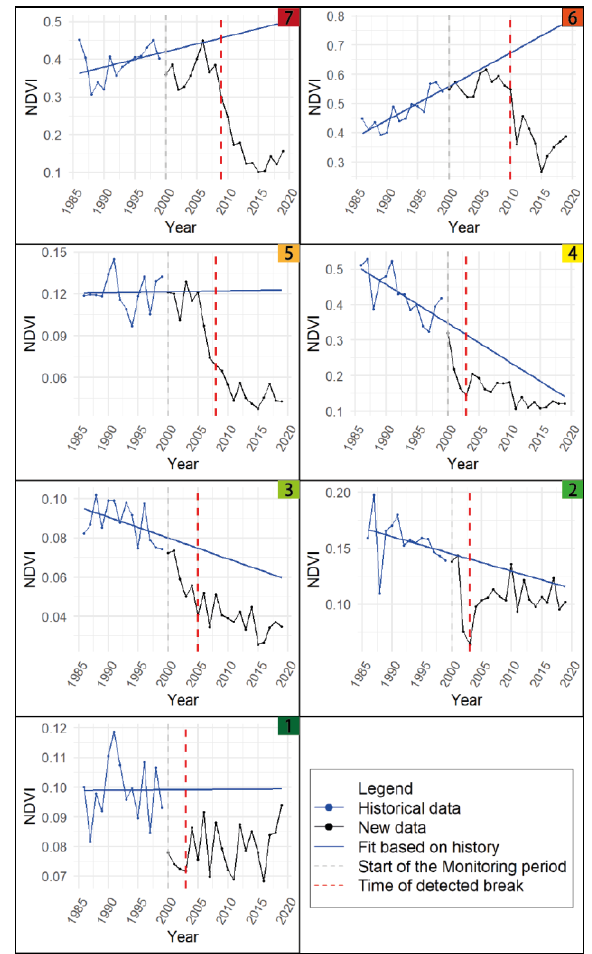
Figure 3. Example of the behavior of pixel time series in the Valle Ancho wetland according to change